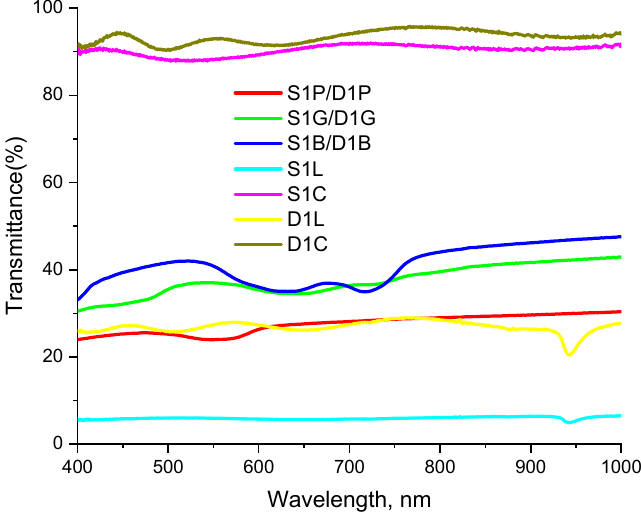
Figure 2. Transfer functions of the studied perturbations (the ratio of the measured spectrum with the perturbation introduced to that in the absence of the perturbation). Perturbations are indicated in accordance with Table 1.